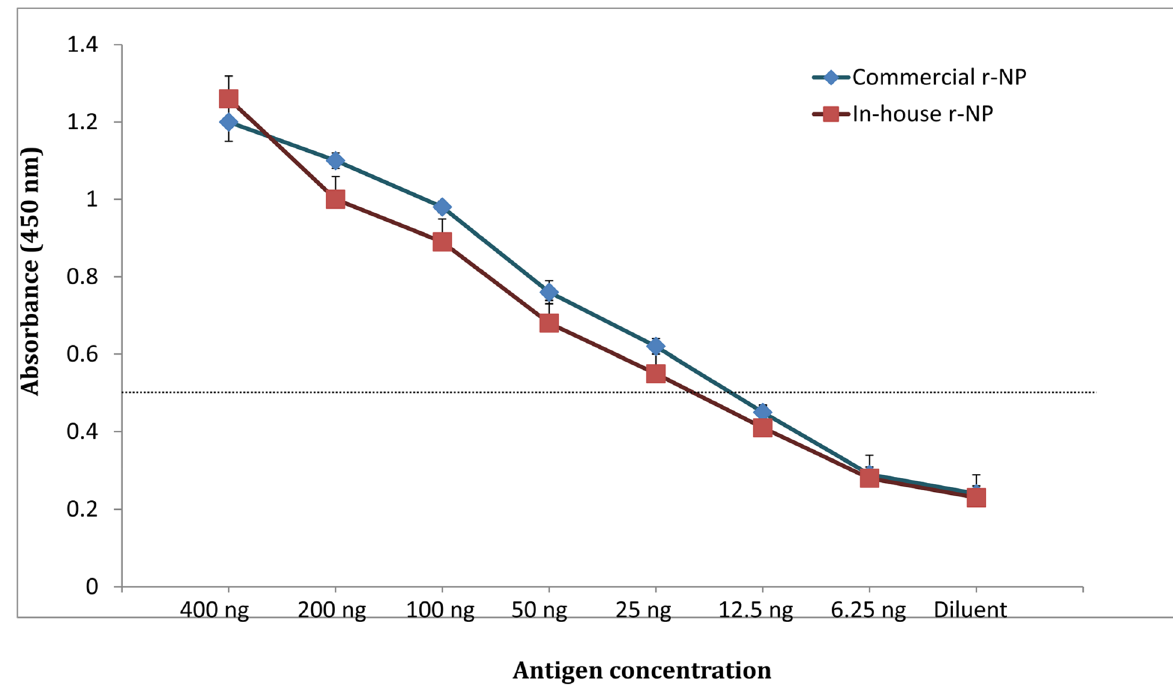
Figure 4. Determination of limit of detection of sandwich ELISA using in-house and commercial CCHF recombinant nucleoprotein antigen. Cut-off value was calculated as twice the value of negative control. Limit of detection was found to be 25 ng of viral nucleoprotein antigen.